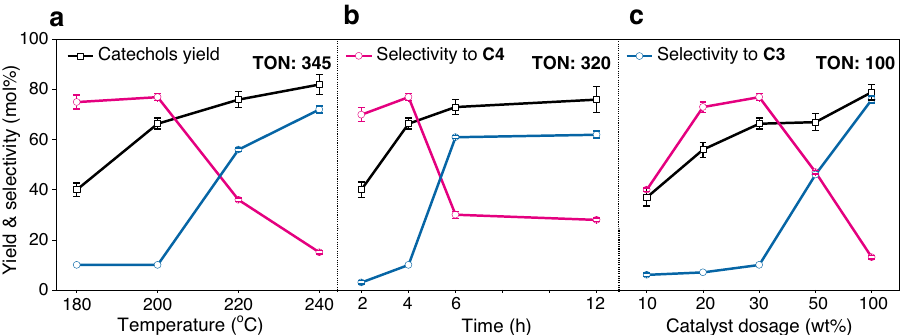
Fig. 4 Parameters effects. a Reaction temperature effect, conditions: C-lignin (50 mg), Ru/ZnO/C (30 wt%), MeOH (10 mL), 3 MPa H 2 , 4 h. b Reaction time effect, at 200 °C, 30 wt% Ru/ZnO/C. c Catalyst dosage effect, at 200 °C, 4 h. (Error bars = standard deviation; n = 2; for 200 °C, 4 h and 30 wt% of Ru/ZnO/C, n = 3; If no error bars are visible, they are smaller than the corresponding symbol size). NATURE COMMUNICATIONS| (2021) 12:416